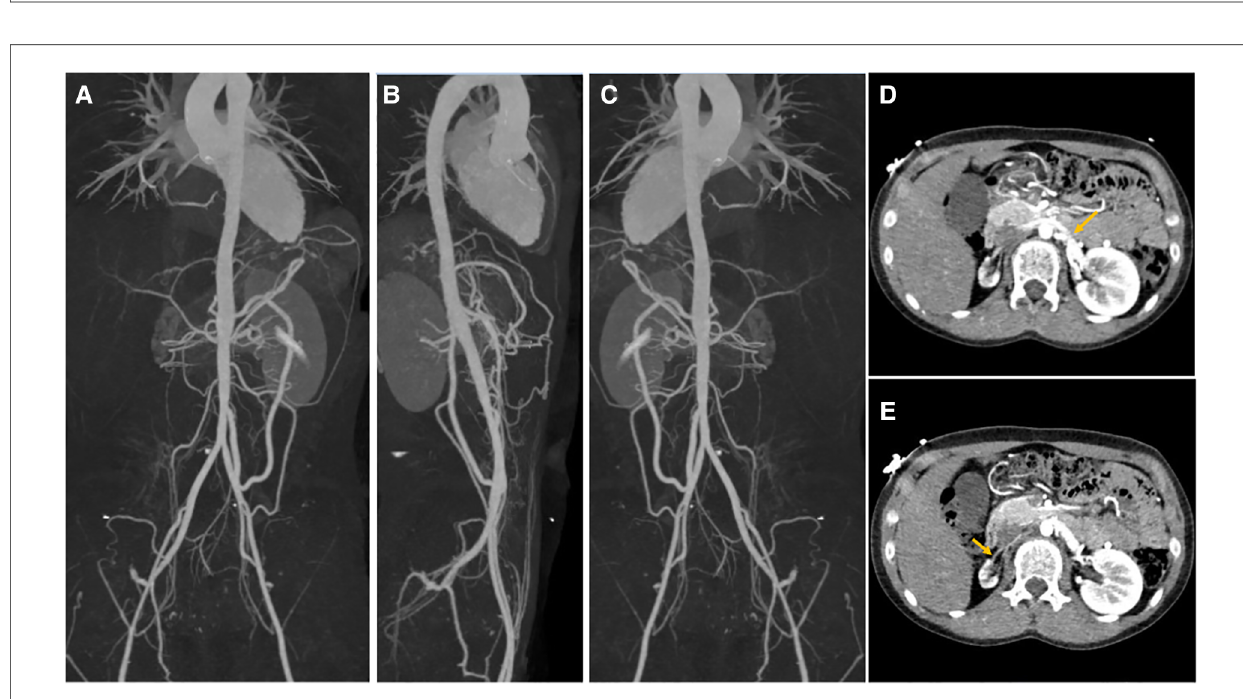
FIGURE 2 Stenosis of cranial and carotid arteries. ( A ) Anterior view, ( B ) posterior view, ( C ) lateral view (left side), ( D ) lateral view (right side), ( E ) stenosis of left ICA, and ( F ) stenosis of right ICA. ICA, internal carotid arteries.